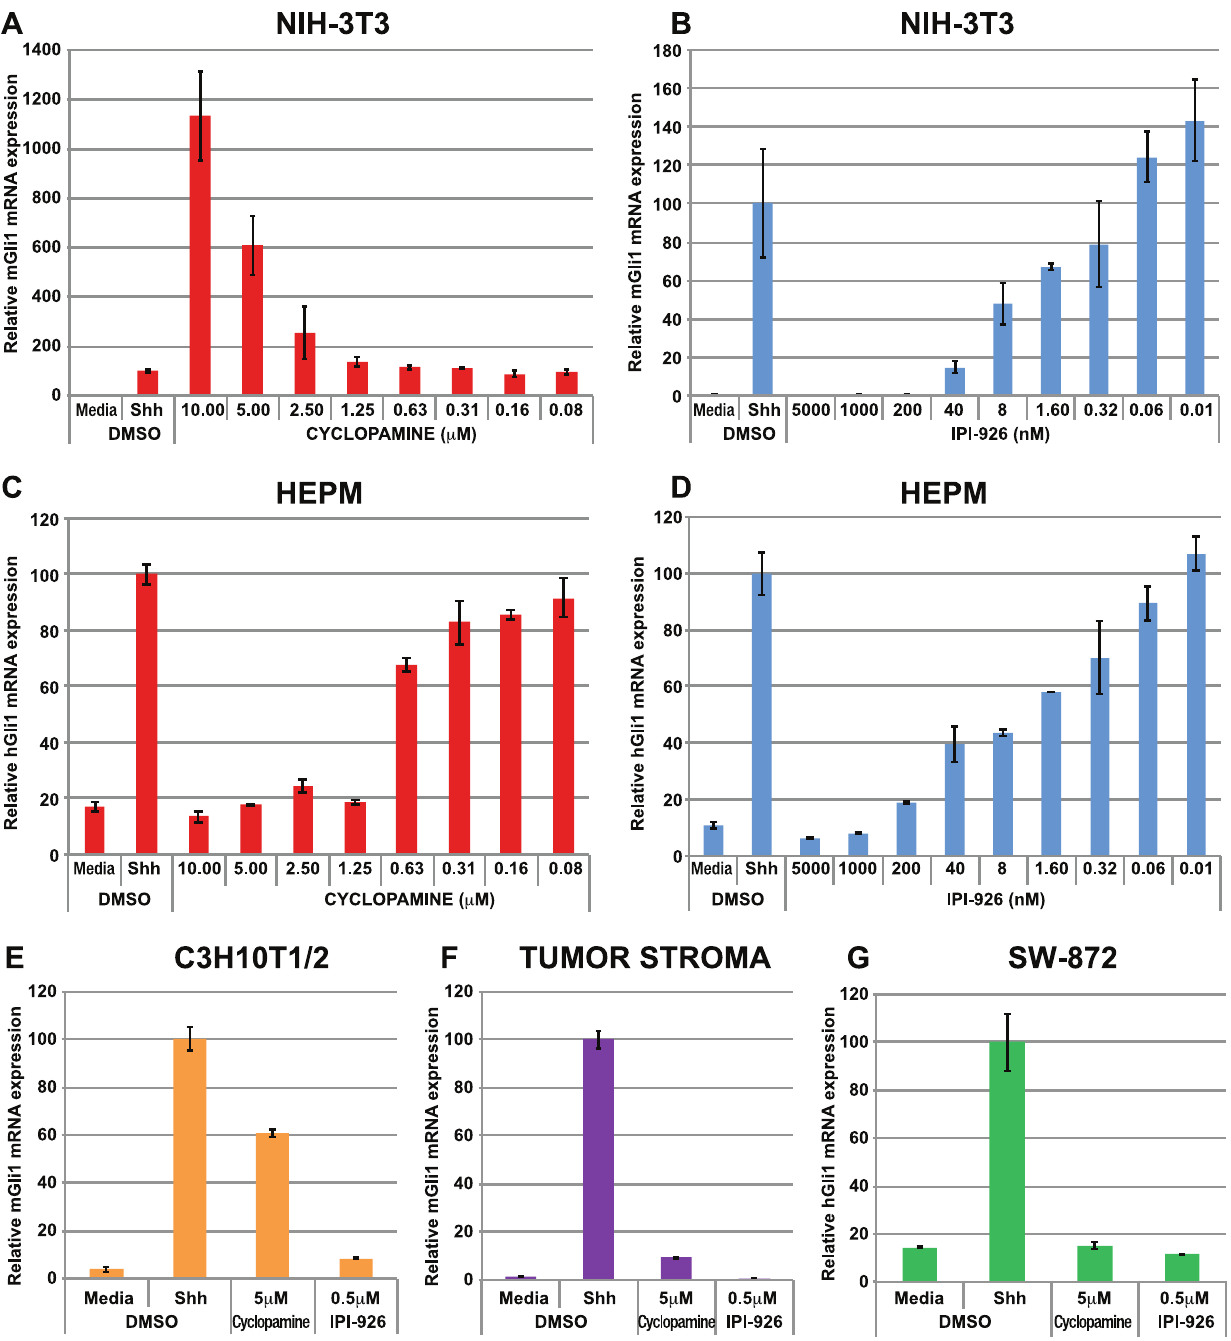
Figure 3. Treatment of NIH-3T3 cells with cyclopamine but not IPI-926 confers hyper-responsiveness to Shh stimulation. Cells were pre-treated with either cyclopamine or IPI-926 for 24 h followed by extensive washing and subsequent treatment with either media alone or media containing 100 nM rShh. Gli1 mRNA levels were assessed by qRT-PCR 21 h post stimulation. Hyper-responsiveness to rShh stimulation is observed in NIH-3T3 cells treated with high doses of cyclopamine (A) but not IPI-926 (B). Note different Y-axis scales between the 2 graphs. Identical experiments carried out in HEPM cells treated with either cyclopamine (C) or IPI-926 (D) does not result in Shh hyper-responsiveness. No Shh hyper-responsiveness was observed in C3H10T1/2 cells (E), pancreatic xenograft tumor stroma (F) or SW-872 cells (G) when pre-treated with 5 m M cyclopamine or 500 nM IPI-926. doi:10.1371/journal.pone.0090534.g003 PLOS ONE |